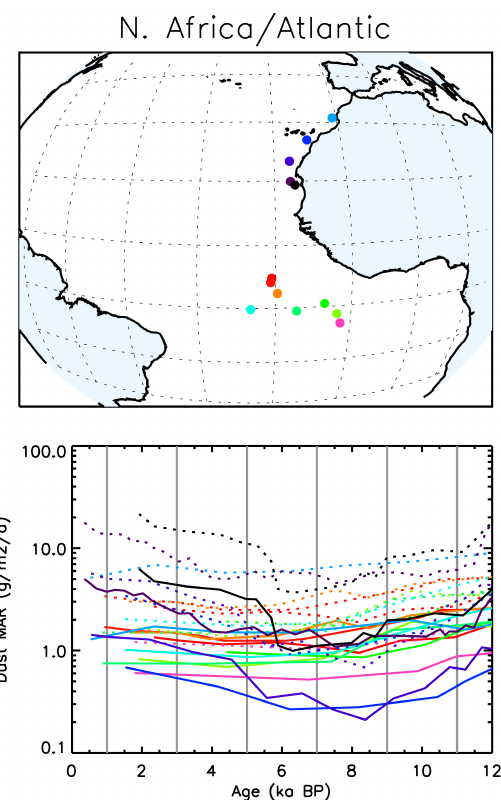
Figure 6. Detailed view of the dust records in the northern Africa– North Atlantic region. Upper panel: geographical location of the pa- leodust records. Bottom panel: time series of the bulk (dotted lines) and “fine”, i.e., <10µm (solid lines), dust MARs. Color-coding is consistent between upper and lower panel. Vertical grey solid lines mark the subperiods within the Holocene as described in Sect. 3.4 at an interval of 2kyr. Please refer to the descriptive sheets in the Sup- plement for a graphical display of the uncertainties for each